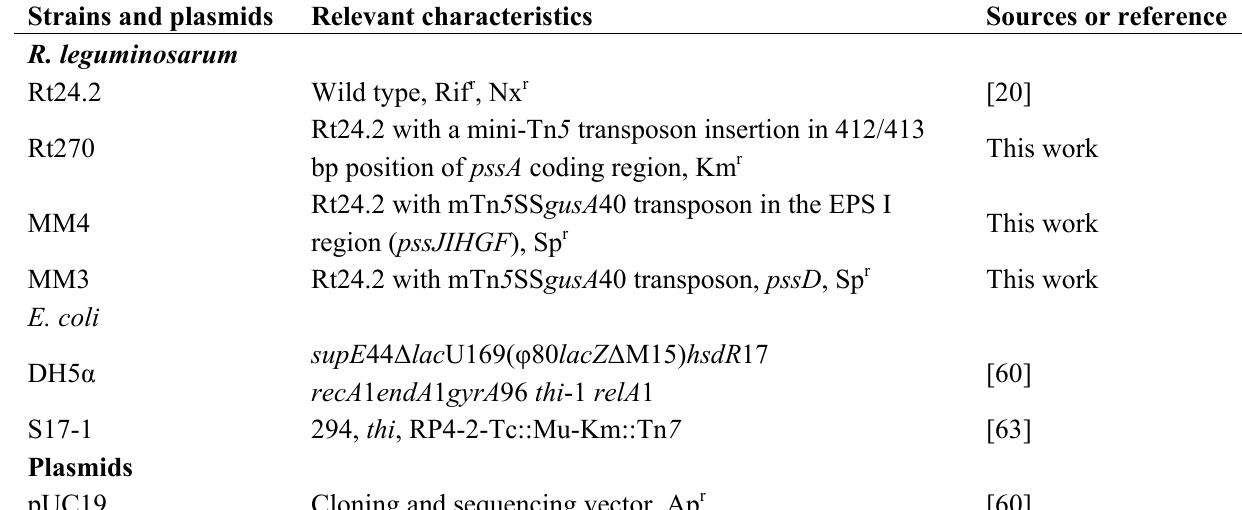
Table 6. Bacterial strains, plasmids, and oligonucleotide primers used in this study. Strains and plasmids Relevant